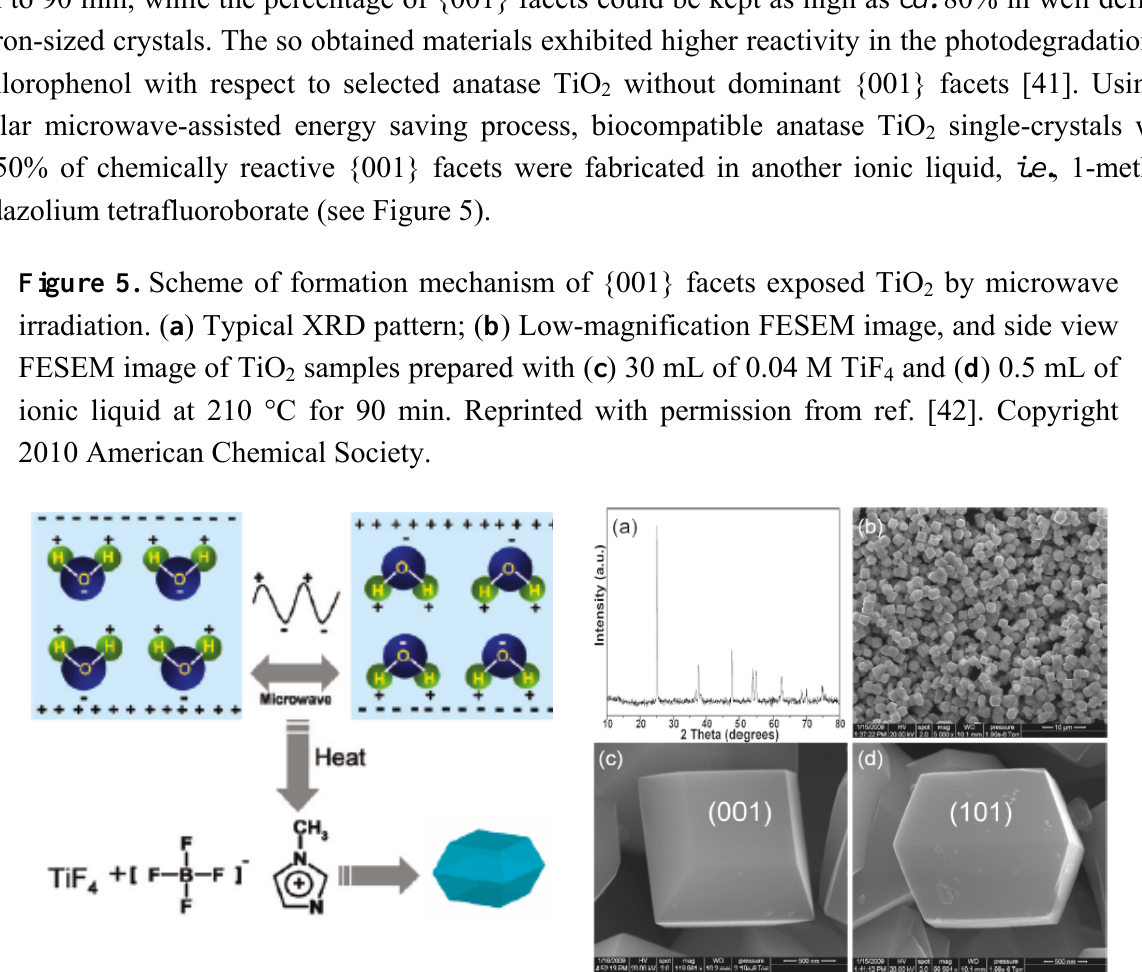
by microwave 2 and ( d ) 0.5 mL of 4